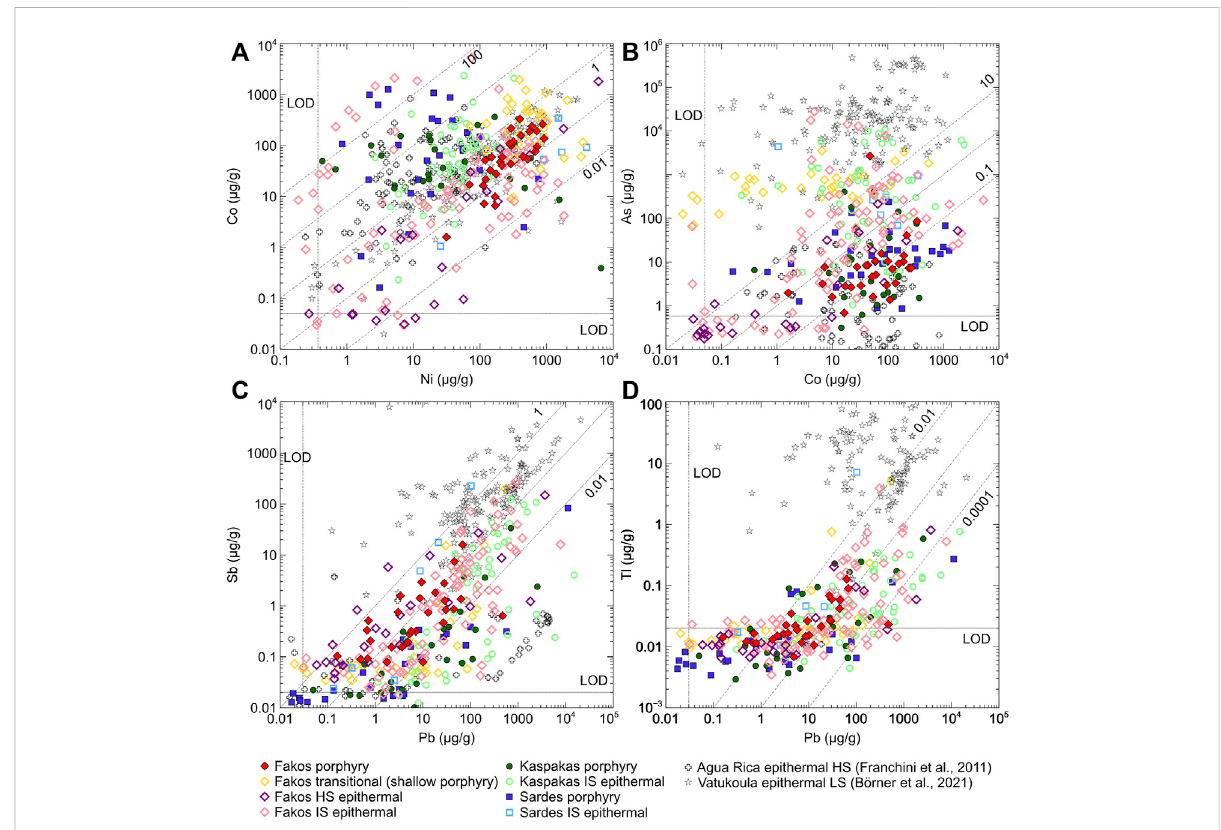
FIGURE 7 Trace element correlation diagrams of pyrite from the different hydrothermal systems and related alteration/mineralization stages: (A) Co-Ni, (B) As-Co, (C) Sb-Pb, (D) Tl-Pb. The data from Agua Rica, Argentina, is from Franchini et al. (2015) and the data from Vatukoula, Fiji, is from Börner